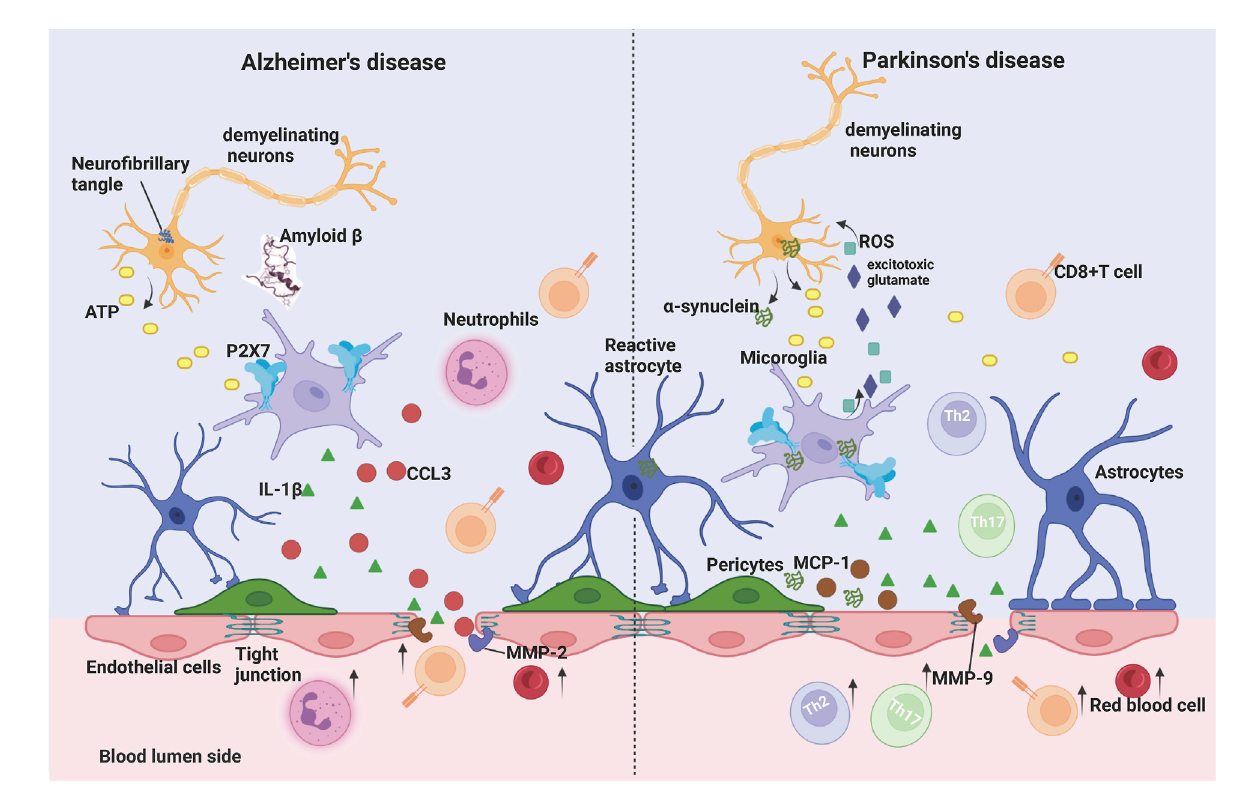
FIGURE 2 Microglia P2X7 receptor signaling on blood-brain barrier permeability in Alzheimer ’ s disease (AD) and Parkinson ’ s disease (PD). In AD, the process of neuronal death induces high levels of ATP release into the extracellular space, which activates microglia P2X7 receptors and leads to the release of IL-1 β . In addition, the ATP/P2X7 receptor pathway enhances metalloproteinase (MMP) activity, leading to degradation of tight junction (TJ) protein, which results in increased blood-brain barrier permeability. A β peptide synergistically promotes P2X7 activation in microglia, which further induces increased release of chemokines such as CCL3 and recruitment of neutrophils and CD8 + T cells into the central nervous system (CNS) in the presence of BBB injury, promoting disease progression. In PD, α -synuclein aggregation leads to dopaminergic neuron death, increased ATP levels and P2X7 hyperactivation. On the other hand, α -synuclein activates microglia, leading to the release of excitatory glutamate and reactive oxygen species (ROS) from microglia to damage dopaminergic neurons, while α -synucleinbinds to and stimulates thetranscriptionofP2X7receptorsinmicroglia. α -synucleinand P2X7 receptors bothincreasetherelease of IL-1 β and chemokines, increase MMP activity, disrupt the BBB, and lead to extravasation of red blood cells, which leads to cerebral microhemorrhage, as well as causing parenchymal in fi ltration of peripheral immune cells and exacerbating the pathological process of PD. Created with